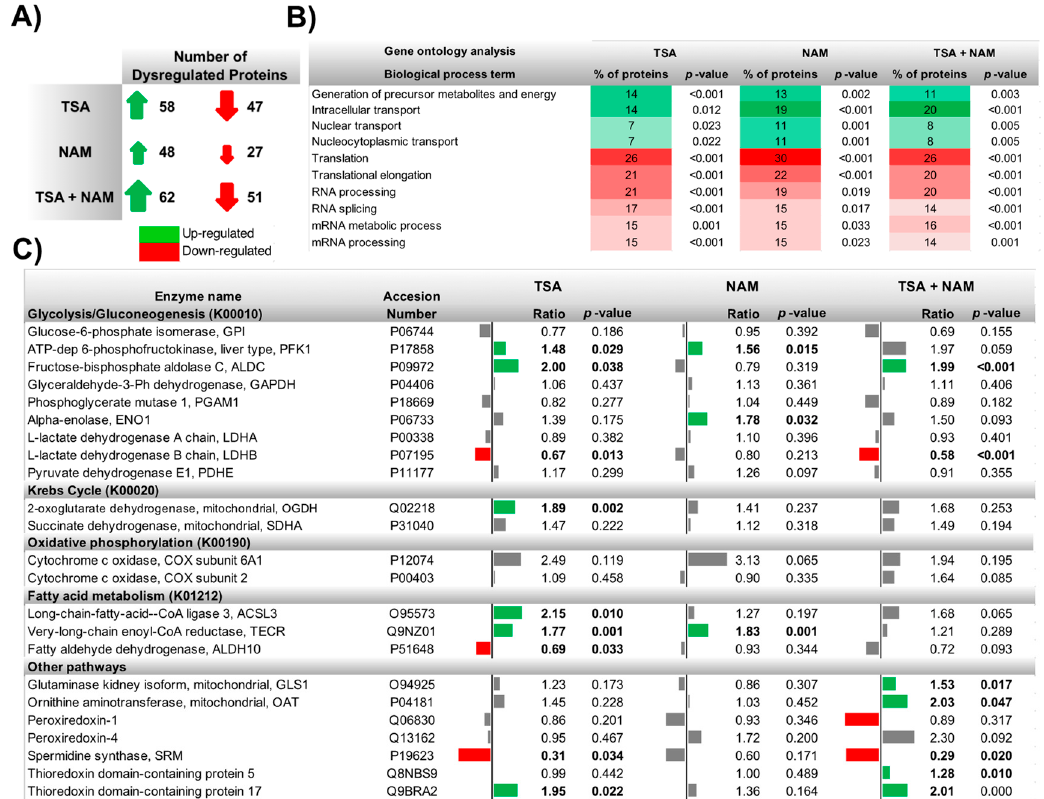
Figure 3. Effect of KDAC inhibition on the global proteome and metabolic enzymes compared to control A549 cells. Quantitative proteomic analysis of differentially expressed proteins in A549 cells treated with 1 µ M of TSA, 20 mM of NAM or both 1 µ M TSA, and 20 mM NAM for 24 h under normoxic conditions. ( A ) The number of up-regulated and down-regulated proteins (isobaric Tags for Relative and Absolute Quantitation (iTRAQ) ratio > 1 and <1, respectively) showing significant ( p -value ≤ 0.05) differences between TSA, NAM and TSA/NAM treatments with respect to control cells. ( B ) GO enrichment analysis of the Biological process term for each condition shown as the percentage of proteins related to each process. All biological processes are shown as significantly ( p -value ≤ 0.05) up-regulated or down-regulated. ( C ) Quantitative measurement of the main metabolic enzymes identified using the iTRAQ approach for the different conditions compared to untreated control cells. Significantly up-regulated enzymes (iTRAQ ratio > 1 and p -value ≤ 0.05) are represented in green and significantly down-regulated enzymes (iTRAQ ratio < 1 and p -value ≤ 0.05) are represented in red. Non-significantly up-regulated, and down-regulated enzymes are represented in